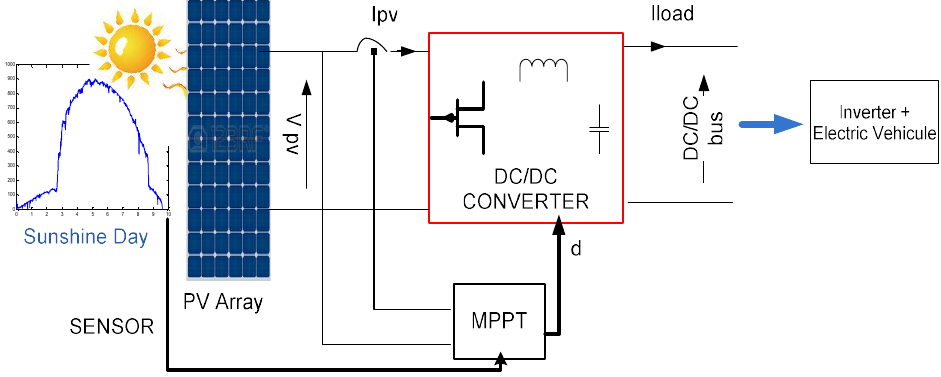
Figure 1. Diagram of the (photovoltaic) electric-vehicle system. PV: photovoltaic; MPPT: maximum power point tracking; DC/DC: direct current/direct current.